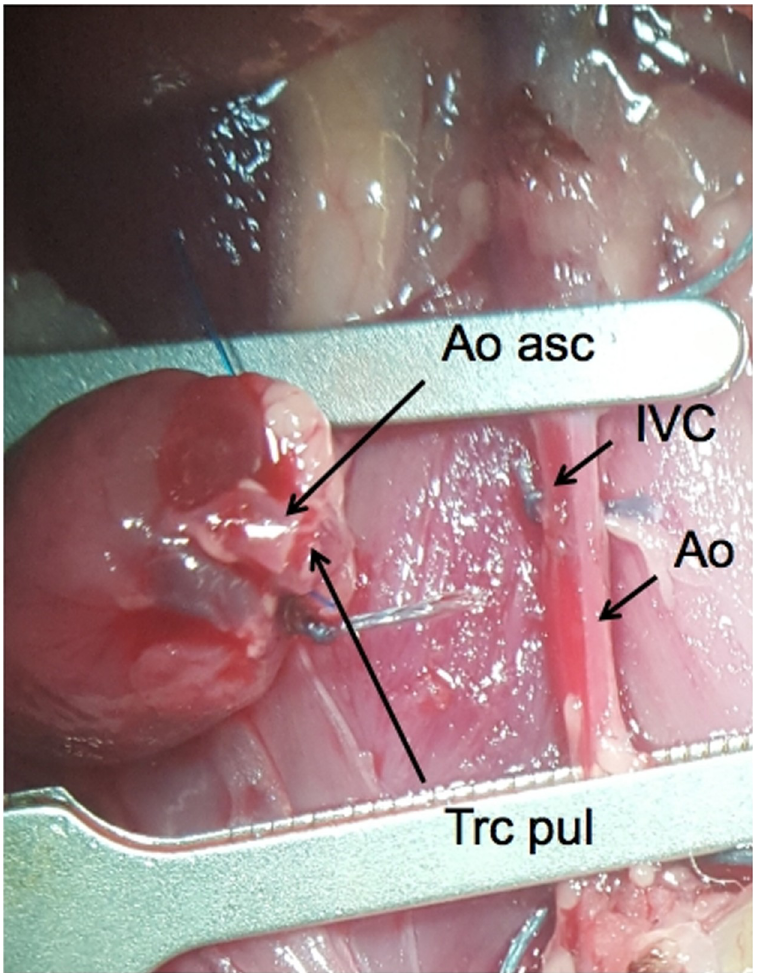
Fig 4. The recipient situs with clamped abdominal vessels. The abdominal aorta (Ao) and the inferior vena cava (IVC) were clamped and prepared for the anastomoses. The donor heart is already situated next to the vessels with the ascending aorta (Ao asc) and the truncus pulmonalis (Trc pul) in place. pulmonary artery and the IVC, so the continuous suture could then be started on the right side of the anastomosis, stitching from outside-to-inside and inside-to-outside (Fig 6C). Using this approach, the heart did not have to be flipped over a second time, improving economy of move- ment and reducing the strain on the vessels. After tying the suture to the proximal anchor knot, the left side of the anastomosis was finished (Fig 6C and 6D). For the venous anastomosis, 5–7 stitches were made on each side. The suture was not tightened firmly and a loop-suture was left in the middle of the first anastomotic side, to prevent congestion. After finishing both anastomoses, warm saline was poured over the heart, and small stripes of a hemostatic agent (Tabotamp, Ethicon, Inc., Somerville, NJ, USA) were draped around the anastomoses. The distal clip was removed first allowing slow retrograde filling of the heart (Fig 7B and 7C) before the proximal clip was released. If necessary, additional hemostasis using cot- ton swabs with light pressure was performed. Typically, the heart would beat spontaneously after a short period of fibrillation. The initial bradycardic heart rate recovered after about 1–2 hours. This process was supported by warming the abdomen with topical application of